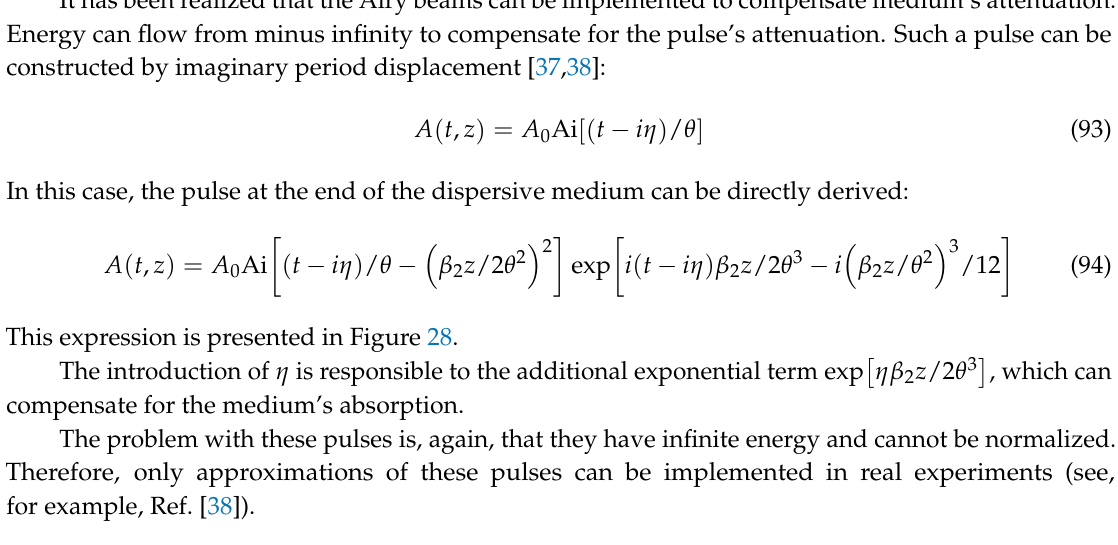
Figure 27. Same as Figure 2, but for the intensity (